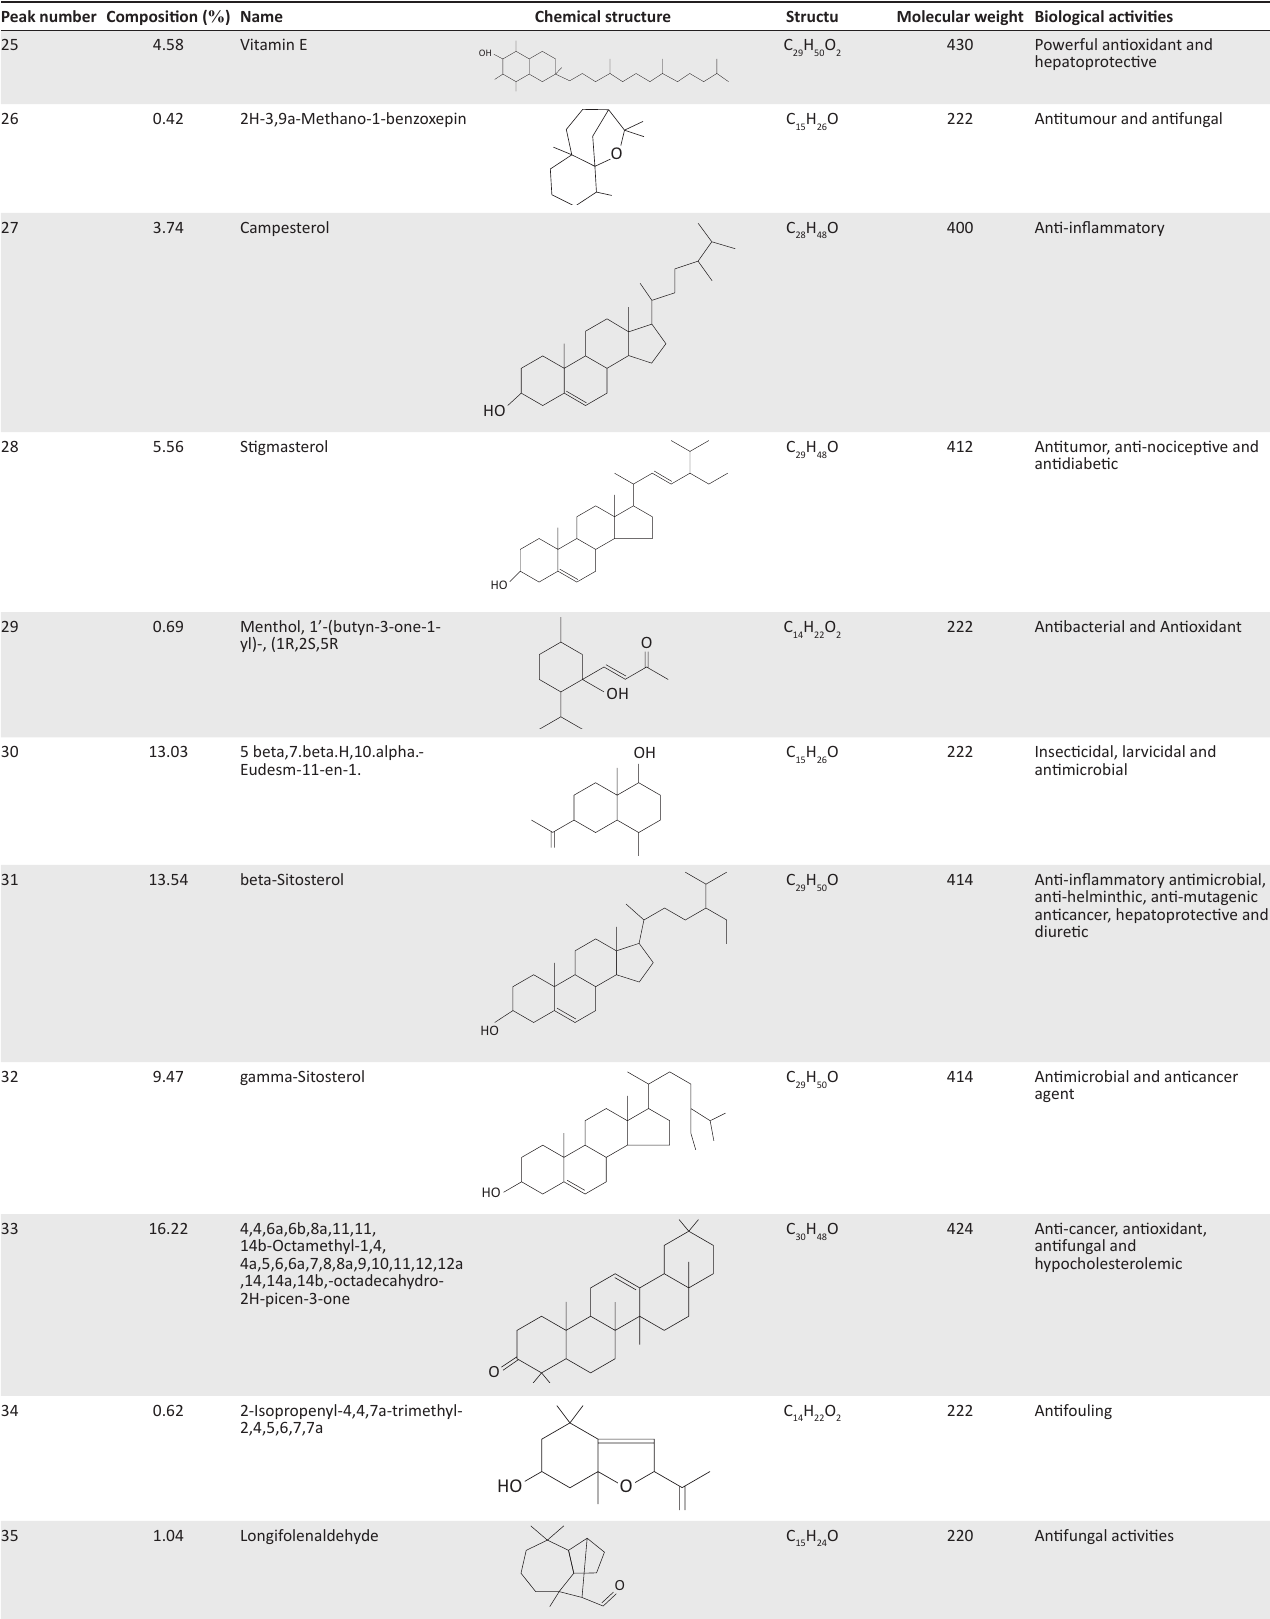
TABLE 1 (Continues...): Chemical compounds in ethylacetate extract of Adansonia digitata identified by gas chromatography–mass spectrometry. Peak number Composition ( % )